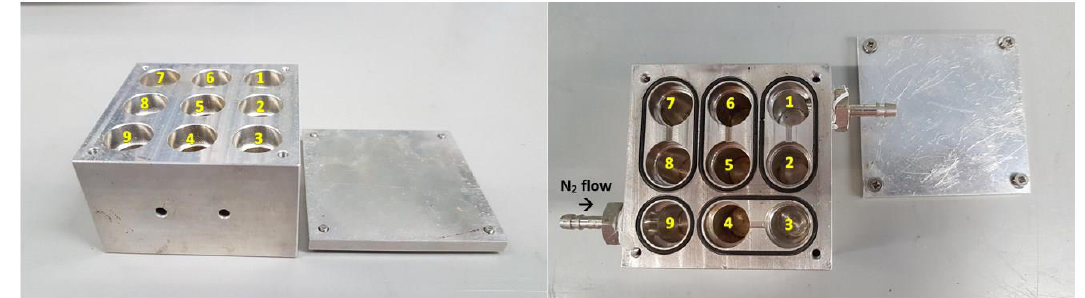
Figure 1. Left: aluminum block used for tests under air. Right: aluminum block with gas inlet and outlet for tests under argon atmosphere.